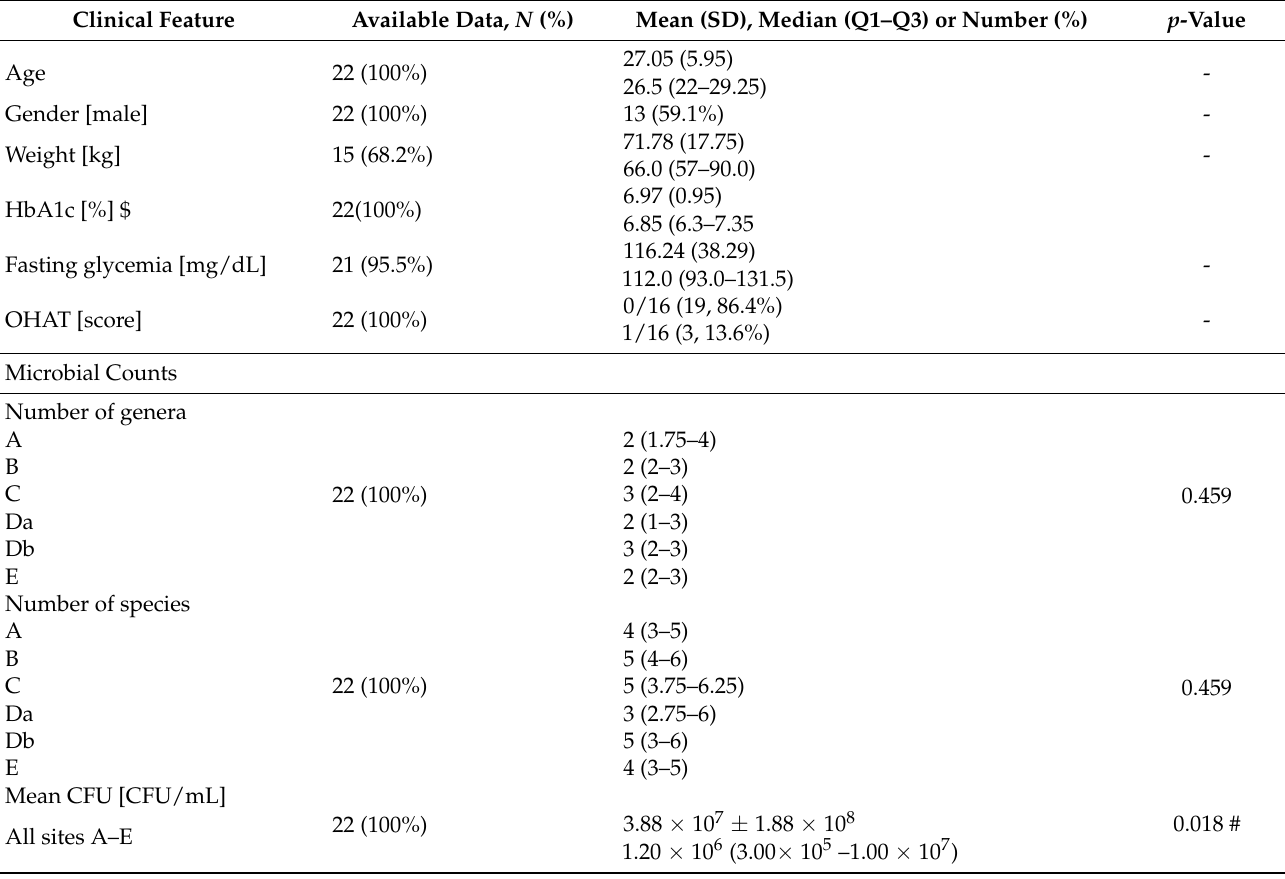
Table 1. Characteristics of the study